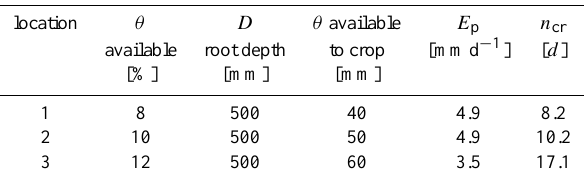
Table 4. Values of critical dry spell length n cr for the three locations indicated in Fig.